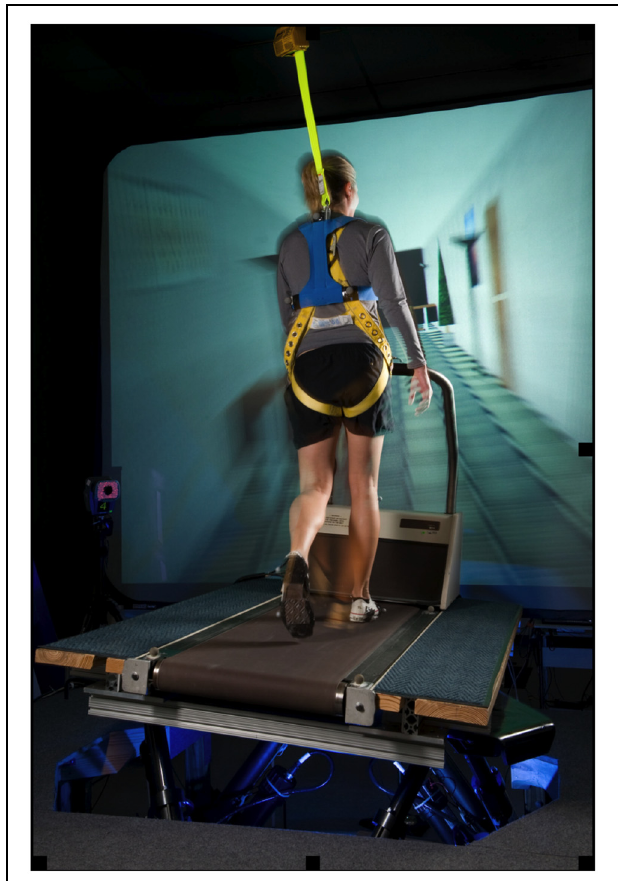
FIGURE 1 | An exemplar subject performing the walking task on a treadmill mounted on a six degree of freedom motion base that provided continuous, sinusoidal, lateral motion of the support surface. Subjects were simultaneously viewing perceptually matched linear optic flow while walking on the